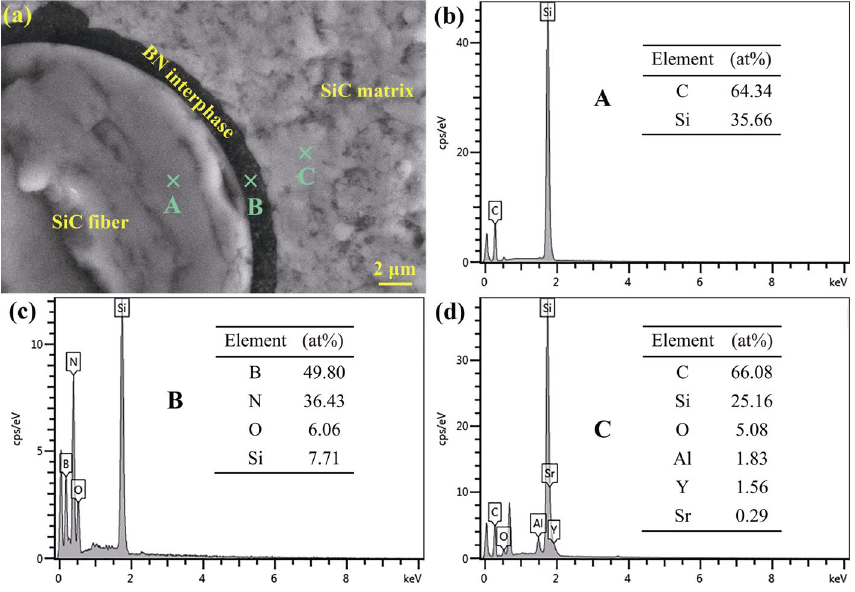
Fig. 2 Energy dispersive spectra of the as-received SiC f /SiC